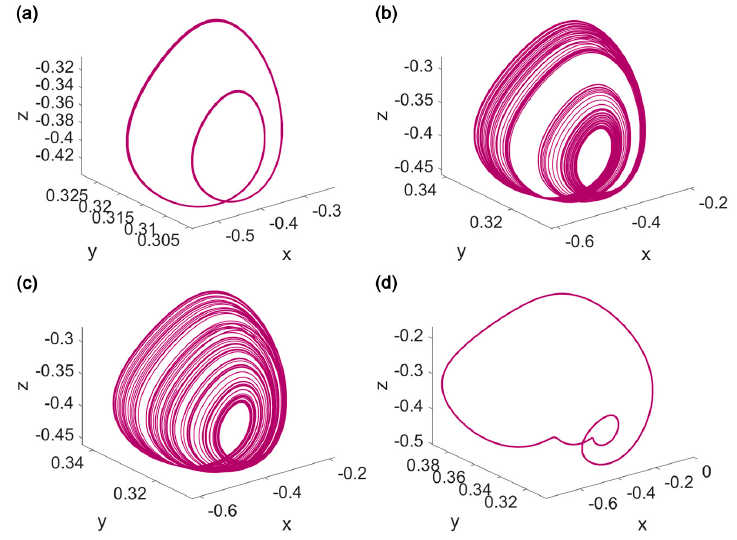
Figure 3. The phase portraits of the FMW neuron for ( a ) α = 0.75 and ( v 0 , r 0 , φ 0 ) = ( 0, − 1,0 ) , ( b ) α = 0.82 and ( v 0 , r 0 , φ 0 ) = ( 0, − 1,0 ) , ( c ) α = 0.83 and ( v 0 , r 0 , φ 0 ) = ( 0, − 1,0 ) , and ( d ) α = 0.95 and ( v 0 , r 0 , φ 0 ) = ( 0,1,0 ) . Other parameters are C m = 1, E Na = 0.95, E K = − 0.95, g K = 26, t r = 5, t φ = 0.5, a = 1, b = 3, k = 8.5, and ε =